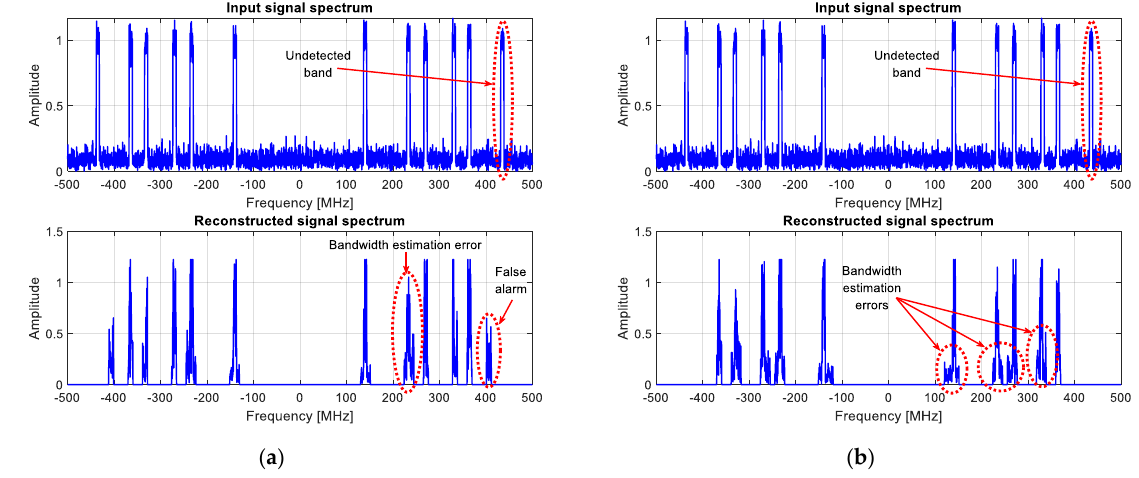
Figure 14. Wideband spectrum sensing results for six active transmitters obtained using two greedy algorithms: ( a ) CoSaMP; ( b )